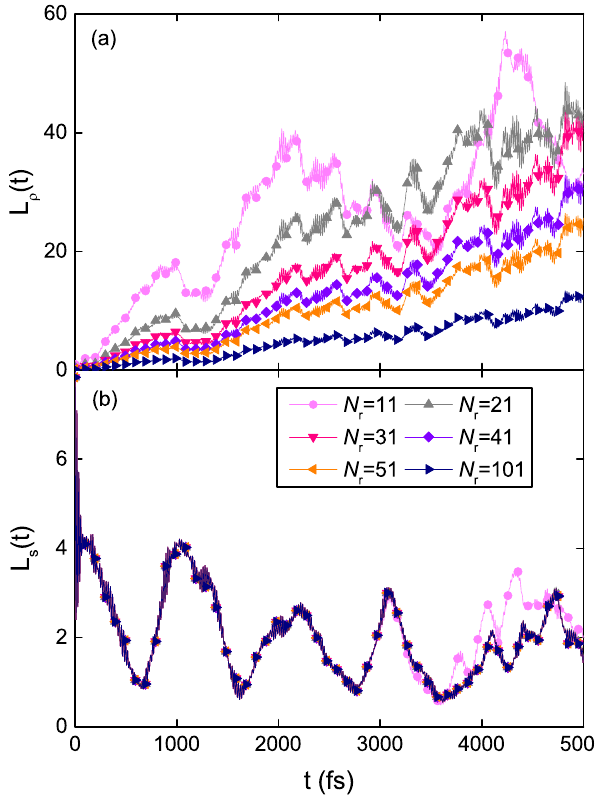
Figure 5. Time evolution of the coherence size L ρ ( a ) and the superradiance enhancement factor L s ( b ) for various B850 chains with the system sizes ranging from 11 to 101 rings. Initially the central ring of the B850 chain is excited to its second lowest exciton